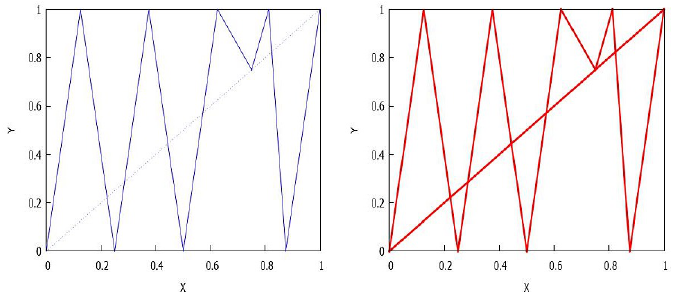
(( z )) homeomorphic to C 0 , z 0 7